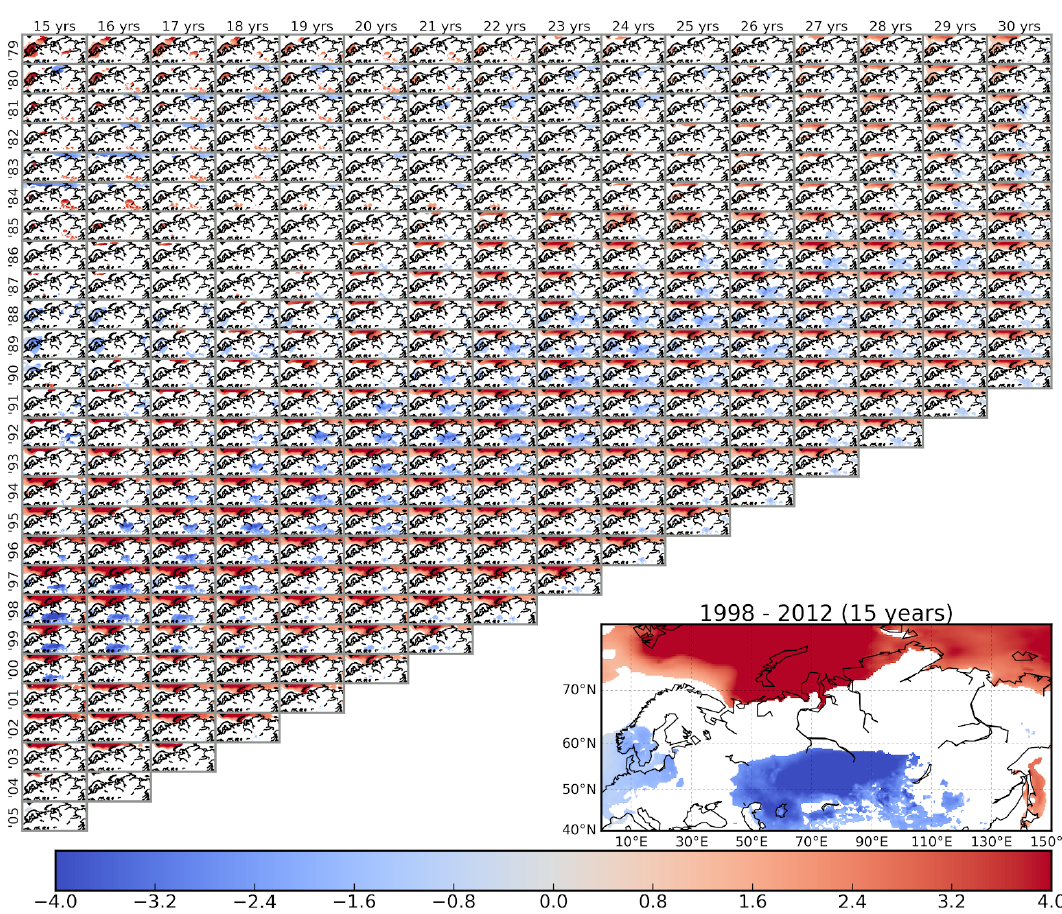
Figure 2. Trends in DJF mean 2m air temperature in ERA5 reanalysis for periods ranging from 15 to 30 years in length (columns) and for starting years ranging from 1979 to 2005 (rows). The domain shown is 0–150 ◦ E and 40–80 ◦ N. Trends are only shown when they differ from the Northern Hemisphere trend over the specified period (95% significance level). The inset (bottom right) shows an expanded view of the panel corresponding to the 15-year period highlighted in Fig. 1a, from DJF 1998 to DJF